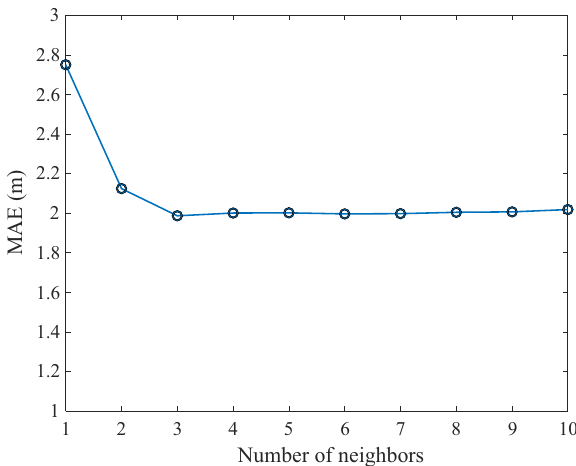
Figure 9. MAE of interpolation using IDW for different number of